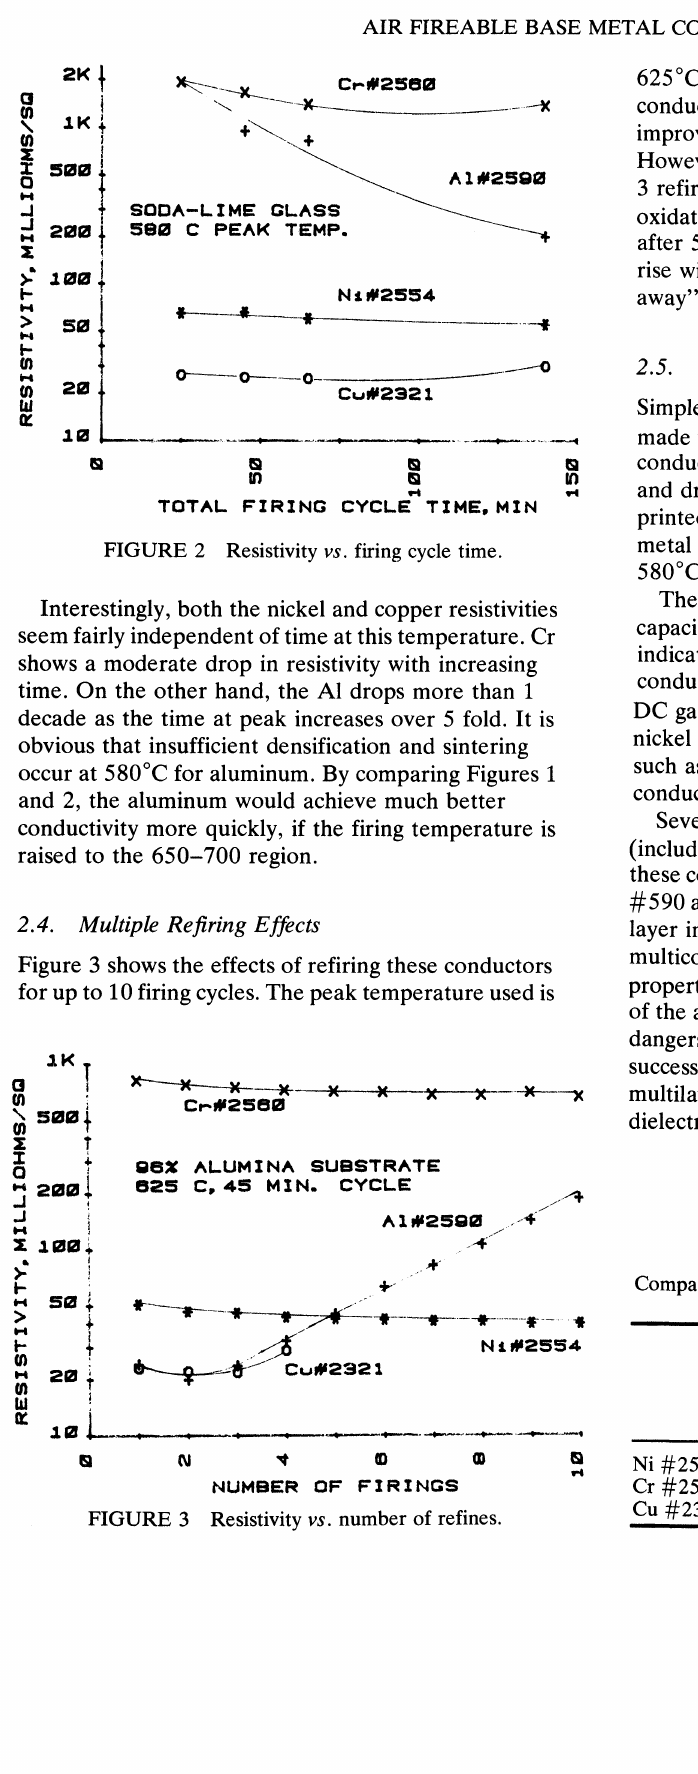
FIGURE 3 Resistivity vs. number of refines.